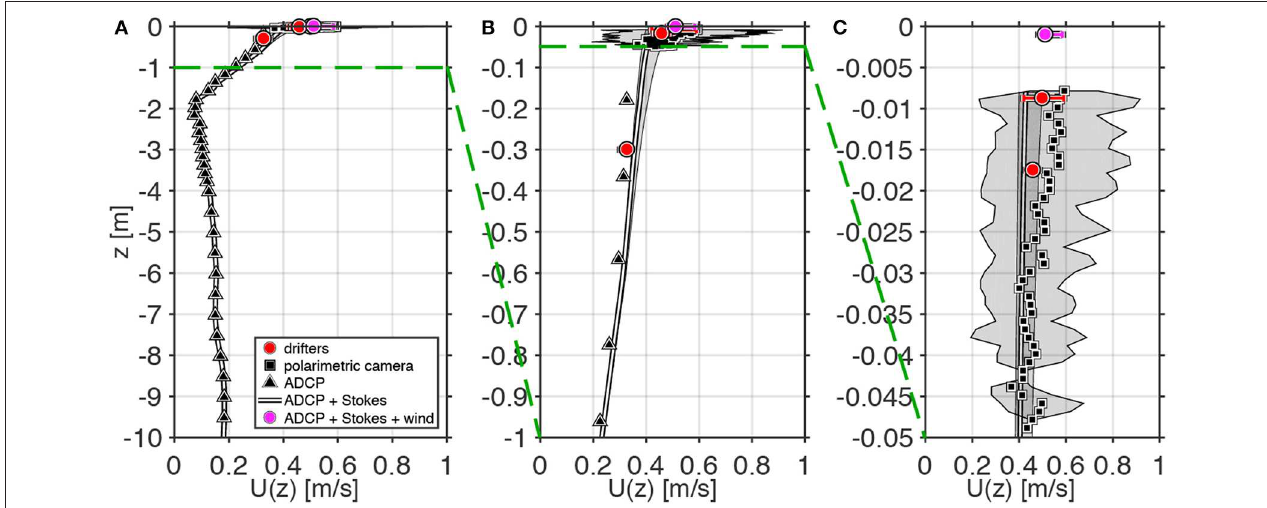
FIGURE 5 | Profile of current speed composited from multiple instruments on 27 April 2017 in the Louisiana Bight over three different depth ranges: (A) Upper 10 m, (B) Upper 1 m, (C) Upper 0.05 m. Symbols indicate different measurement platforms: triangles-ADCP; squares-polarimetric camera; line-Stokes drift plus ADCP; magenta circle-Stokes drift plus ADCP current plus empirical 8.5 cm/s wind forcing drift; red circles-centroid speeds of bamboo plates and drifters. Shaded regions (polarimetric current, Stokes drift plus ADCP) and horizontal bars (drifting instruments) define the 5th–95th percentile range. The darker shaded region in (C) represents the 5th–95th percentile range of the Stokes drift. From Laxague et al. (2017), see paper for details.